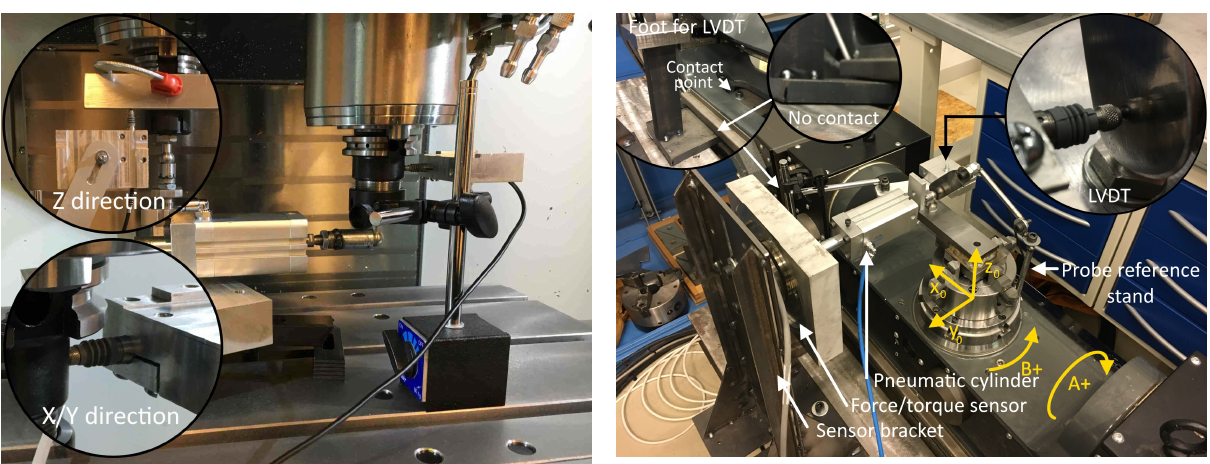
Figure 9: 2-axis trunnion: test setup using LVDT, pneumatic cylinder and force/torque sensor. in Position 4.